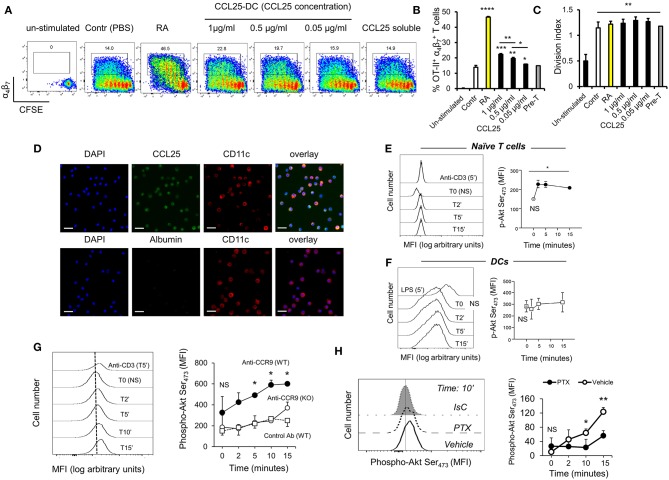
CCR9 signals promote the acquisition of gut-homing receptors during in vitro T cell activation. (A–C) OT-II T cells were labeled with CFSE (4 μM) and stimulated with OVA323−339-pulsed mature C57/Bl6 bone-marrow (BM)-derived DCs pre-treated with increasing concentrations of CCL25 (pre-DC) or PBS alone. As a control, T cells were activated in the presence of retinoic acid (RA) or pre-treated with CCL25 and subsequently exposed to untreated antigen-presenting DCs (pre-T). After 3 days, expression of the integrin α4β7 by CFSElow T cells was assessed by flow cytometry. The bar graph shows the mean data from three experiment of identical design each performed in triplicate (±SEM). In panel (C), the stimulation index calculated for the different cultures is shown (N = 3). Asterisks over each column bar represent comparison with control. Asterisks over lines represent comparisons between the columns included between the lines. (D) Representative confocal microscopy image of non-permeabilized DCs incubated with green Dylight 488-labeled CCL25 (300 ng/ml) or albumin (control) and counter-stained with Hamster-anti-mouse CD11c. Scale bar = 40 μm. (E,F) Naïve T cells (E) or DCs (F) were exposed to CCL25 (300 ng/ml) for up to 15 min and phosphorylation of Akt at serine 473 was assessed by antibody staining and flow cytometry. Representative histograms of the experimental conditions indicated beside each profile are shown in the left-hand panels. pAktSer473 expression by non-stimulated T cells or DCs (T0, NS), and by T cells and DCs stimulated for 5 min with anti-CD3 (1μg/ml) or LPS (100 ng/ml), respectively, are shown. The right-hand panels show the mean fluorescence intensity (MFI) indicative of Akt phosphorylation obtained in 3 experiment of identical design each performed in triplicate (±SEM, *p < 0.05 vs. NS). (G,H) Purified naïve T cells were exposed to the NB100-708 anti-CCR9 antibody (5 μg/ml) cross-linked with 2.5 μg/mL Donkey–anti-goat IgG for up to 15 min and phosphorylation of Akt at serine 473 (pAktSer473) was assessed by flow cytometry. (G) Representative histograms of T cells stained with the pAkt-specific antibody are shown in the left-hand panel. pAktSer473 expression after 5-min stimulation with anti-CD3 is shown. The mean MFI values obtained at the indicated time points obtained in three experiments of identical design each performed in triplicates is shown on the right-hand panel (±SD, *p < 0.05, **p < 0.01 vs. time 0, NS), which includes pAktSer473 expression by CCR9-competent T cells in the presence an Isotype-matched antibody (IsC) (WT) and by ccr9−/− T cells (KO) incubated with the anti-CCR9 Ab. (H) In some T cells CCR9 was antibody-activated in the presence of pertussis toxin (PTX, 0.1 μg/ml). A histogram displaying pAktSer473 measured at 10 min after stimulation is shown on the left hand side. The mean MFI values obtained in three experiments of identical design each performed in triplicates are shown in the right-hand panel (±SD). *p < 0.05, **p < 0.01, ***p < 0.001, ****p < 0.001.